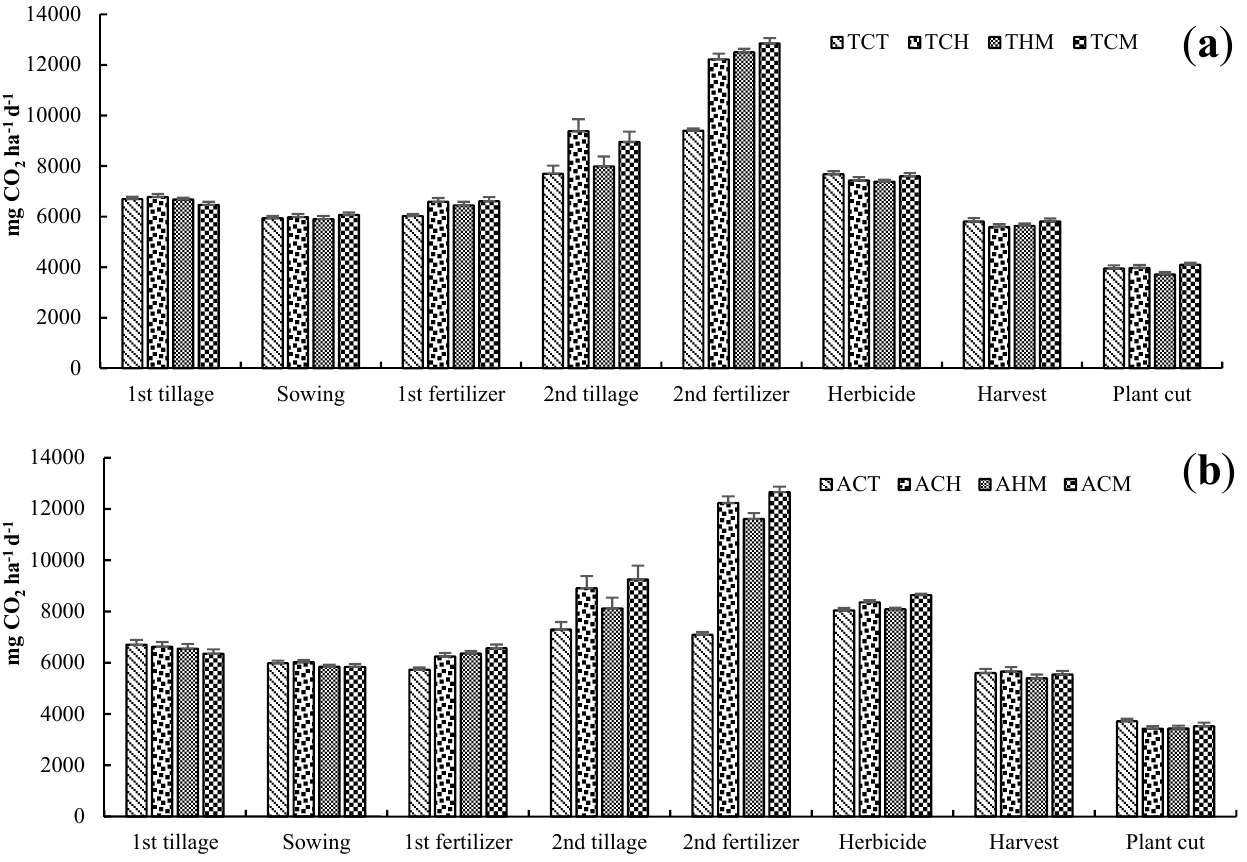
Figure 2. Mean soil CO 2 emission rate during different crop growth periods under different tillage and nitrogen fertilizer treatments. ( a ) Tillage tractor; ( b ) animal traction. TCT, tractor unfertilized control; TCH, tractor chemical fertilizer; THM, tractor horse manure; TCM, tractor chicken manure; ACT, animal unfertilized control; ACH, animal chemical fertilizer; AHM, animal horse manure; ACM, animal chicken manure. The error bars represent the sample population variation. Table 4. Shows the significant differences between the treatments (CO 2 m − 2 h − 1 ).